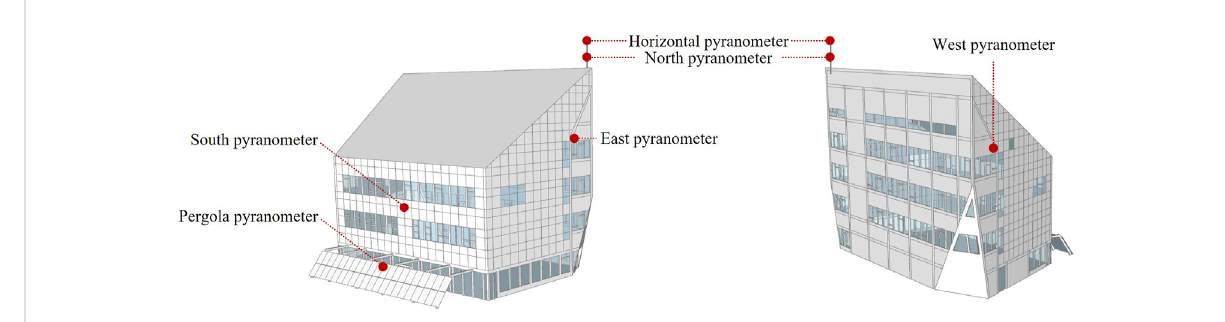
FIGURE 4 Location of the pyranometer in the ZEB